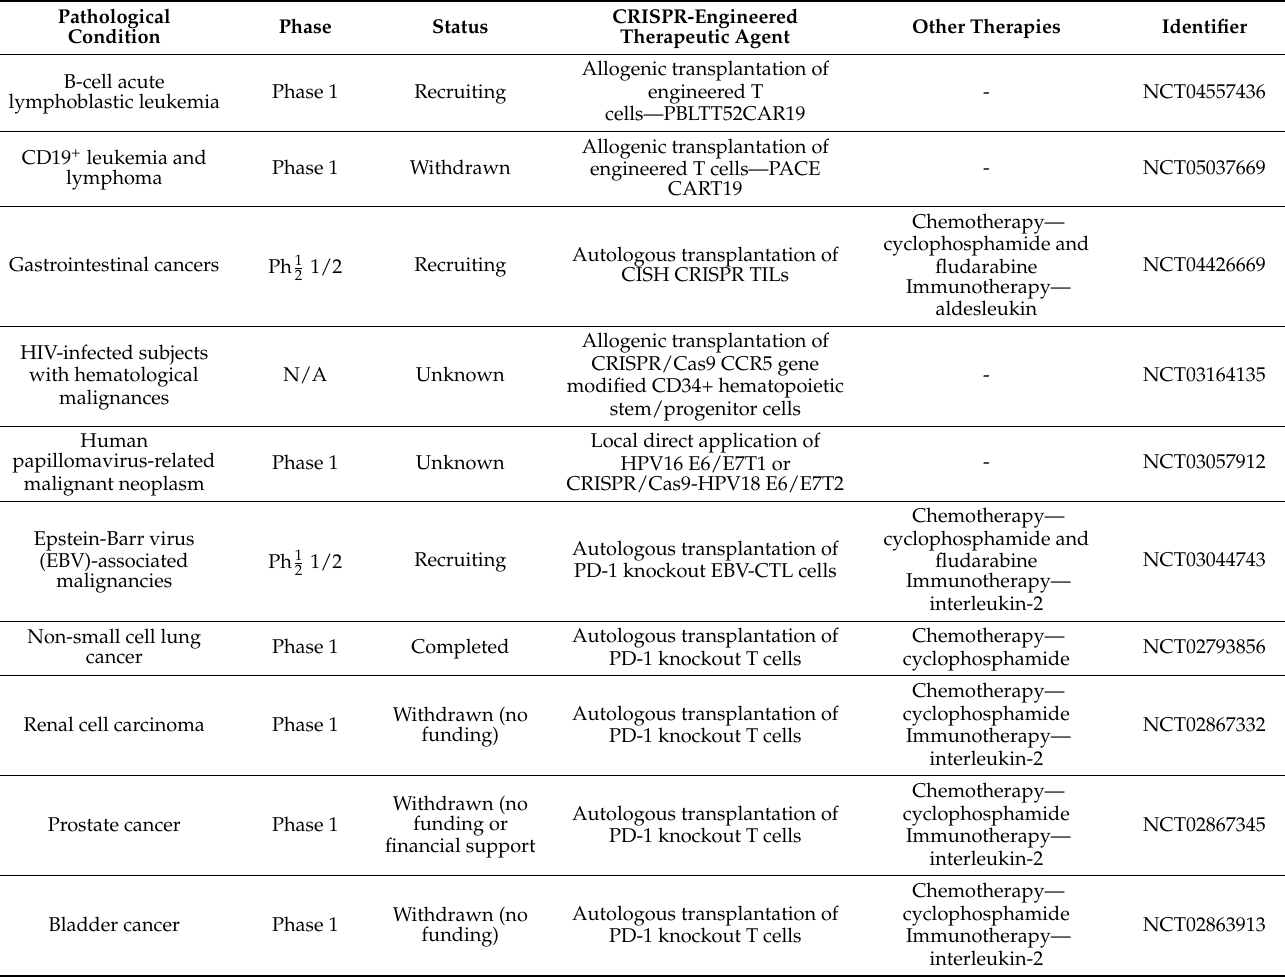
Table 1. List of clinical trials using CRISPR technology for cancer